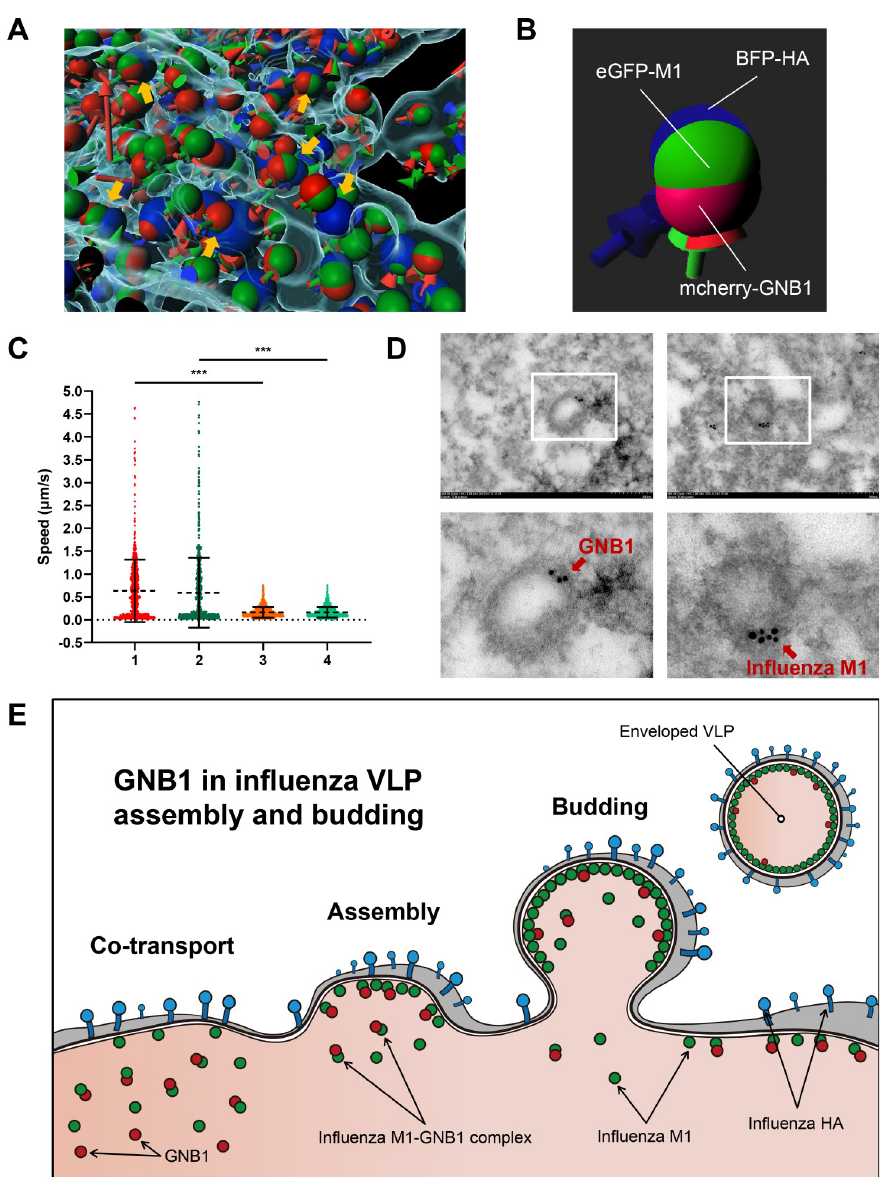
Fig 7. GNB1 protein co-transported with M1 protein in A549 cells. (A) A549 cells were transfected with eGFP-M1 , BFP-HA , and mCherry-GNB1 expression plasmids. Cross-section through the volume depicts the signal from the three channels. Yellow arrowheads indicate the co-localized puncta corresponding to co-transport of eGFP-M1 and mCherry-GNB1 to BFP-HA (S1 Movie). The blue, green, and red arrows or balls represent the tracks or punctas of BFP-HA, eGFP-M1, and mCherry-GNB1, respectively. (B) Enlarged view of the combination of H9N2-derived eGFP-M1, BFP-HA, and mCherry-GNB1. (C) Live-cell imaging illustrating the dynamic movement of the fluorescent fusion protein puncta within a cell with a similar number of spots and tracks between H9N2-derived eGFP-M1/ BFP-HA/mCherry-GNB1 and H5N1-derived eGFP-M1/BFP-HA/mCherry-GNB1 transfected cells, which quantifies the track speed (ratio of track length to track duration [ μ m/s]) to characterize the intracellular movement. Each datapoint represents a punctum from the corresponding channel for the motion parameters (track speed) of eGFP-M1 singletons and mCherry-GNB1 singletons. “1” and “2” denote the speed of mCherry-GNB1 and H9N2-derived eGFP-M1 in H9N2-derived eGFP-M1/BFP-HA/mCherry-GNB1, respectively. “3” and “4” denote the speed of mCherry-GNB1 and H5N1-derived eGFP-M1 in H5N1-derived eGFP-M1/BFP-HA/mCherry-GNB1, respectively. (D) IEM analysis of influenza virus in the supernatant from infected cells. A549 cells were infected with rM14:M-H9N2 virus at an MOI of 1. At 24 hpi, supernatants from infected cells were collected for IEM. Anti-GNB1 or anti-influenza M1 antibody were used as the primary antibody. The gold is 10 nm in diameter. (E) Proposed model of the roles of GNB1 in viral assembly and budding of influenza VLPs.